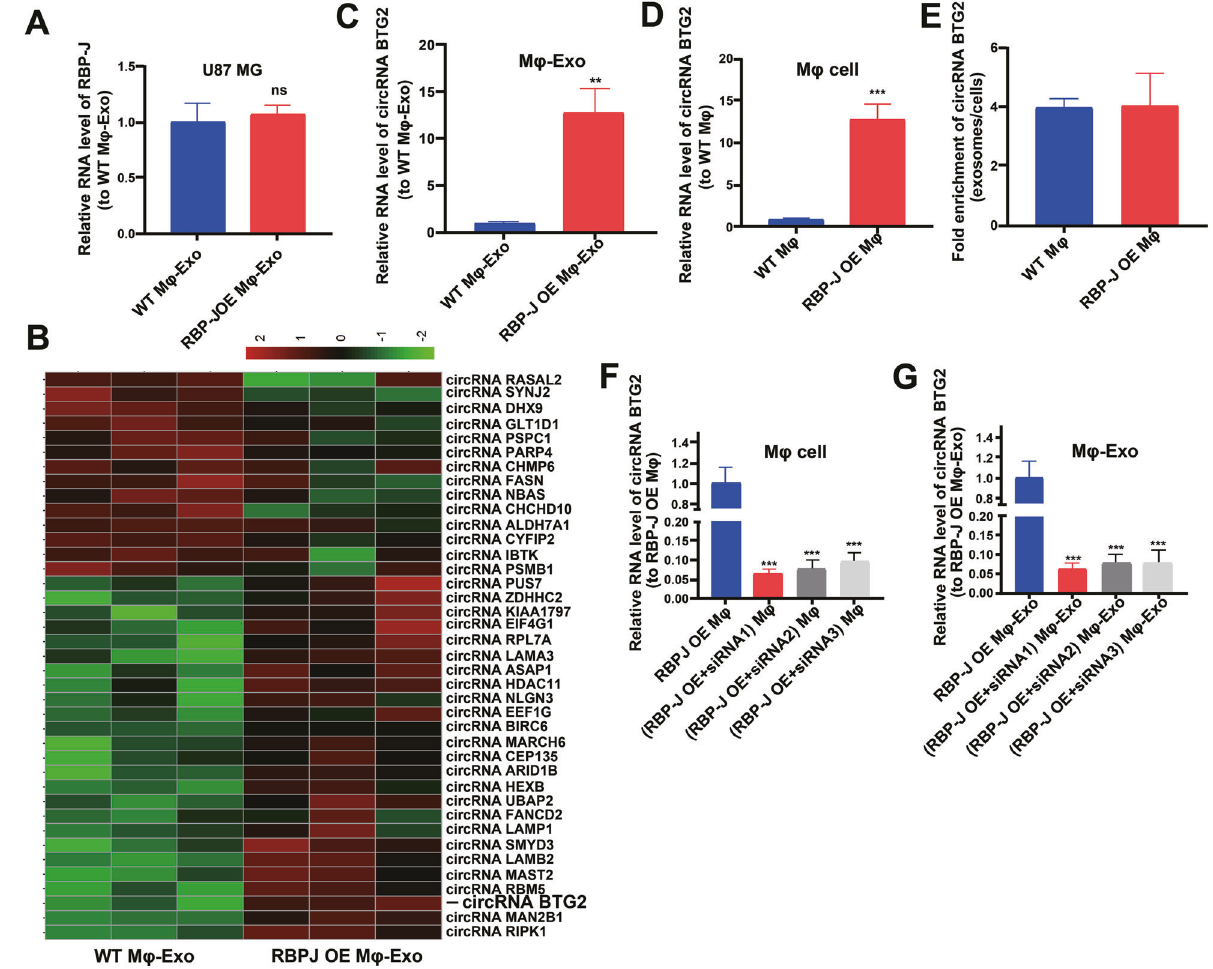
Fig. 3 circRNA expression pro fi les in exosomes derived from RBP-J -overexpressed macrophages. A The relative expressions of RBP-J in WT M φ -Exos treated U87 MG cells and RBP-J OE M φ -Exos treated U87 MG cells were detected by qRT-PCR. B Cluster heatmap showing 39 aberrantly expressed circRNAs, including 25 upregulated and 14 downregulated circRNAs in exosomes derived from RBP-J -overexpressed macrophages compared to the controls. The red color represents high expression, whereas the green color represents low expression. C , D The relative expression of circRNA BTG2 in M φ -Exo ( C ) and M φ cells ( D ) was validated by qRT-PCR. E The fold change of circRNA BTG2 expression between the exosomes and their corresponding producer cells. F , G The qRT-PCR assay indicated the difference in the circRNA BTG2 expression in RBP-J -overexpressed M φ cells transfected with or without si-circRNA ( F ), as well as in exosomes from those cells ( G ). ** P < 0.01 and *** P < 0.001 for statistical differences, ns: no signi fi